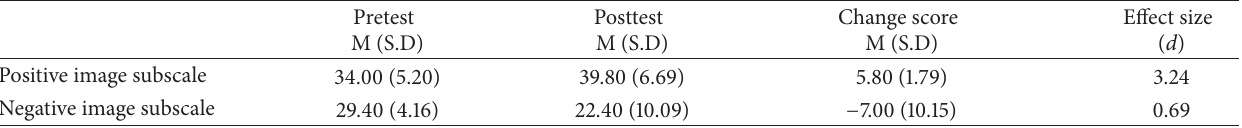
Table 1: Descriptive